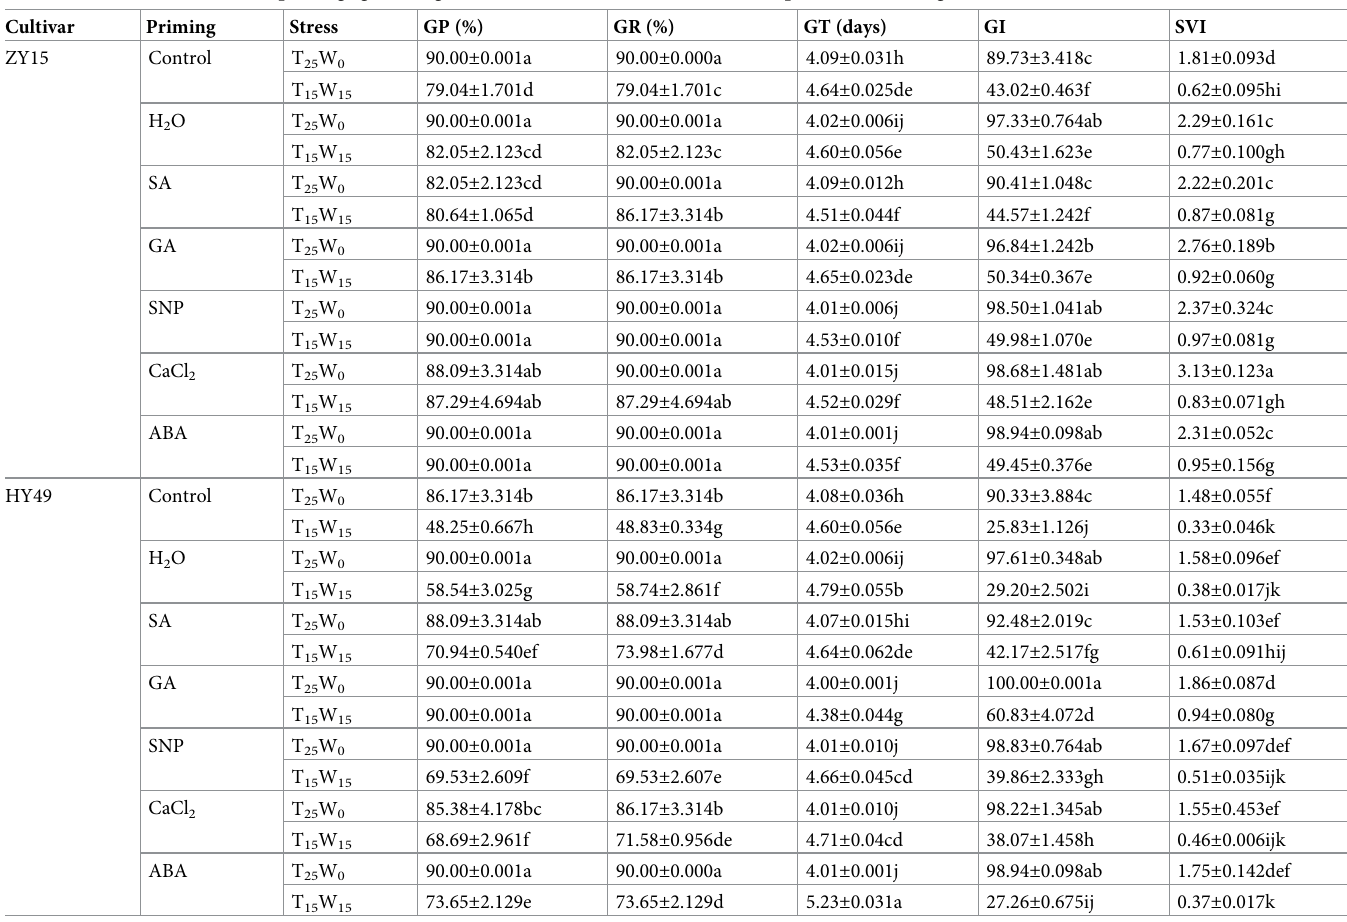
Table 1. Effects of different seed priming agents on germination characteristics under low temperature and drought conditions. Cultivar